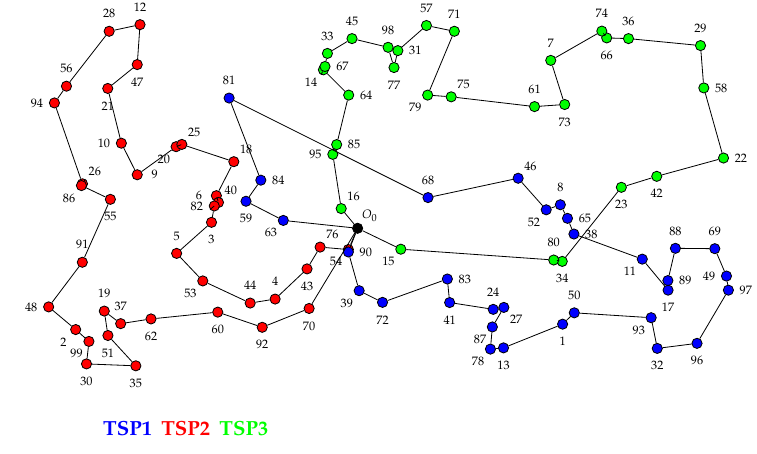
Figure 8. Tour for 3TSP100.